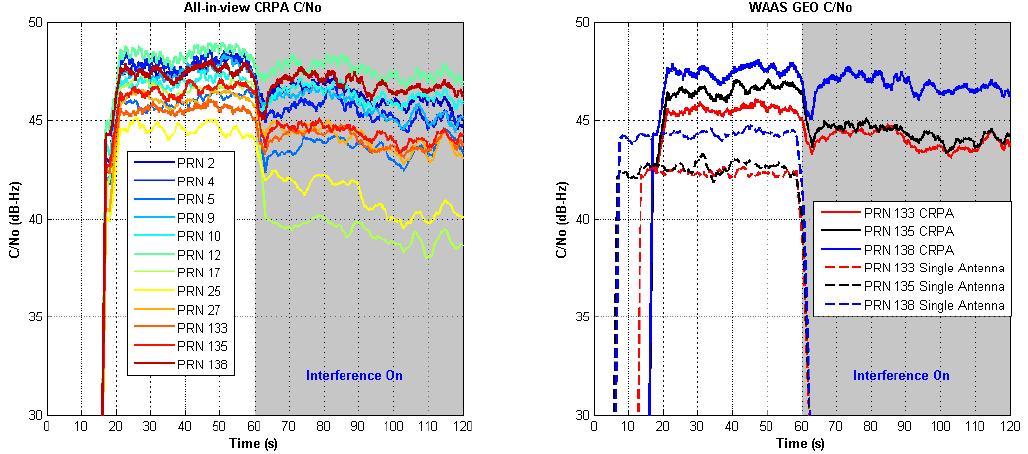
of three WAAS GEO 0